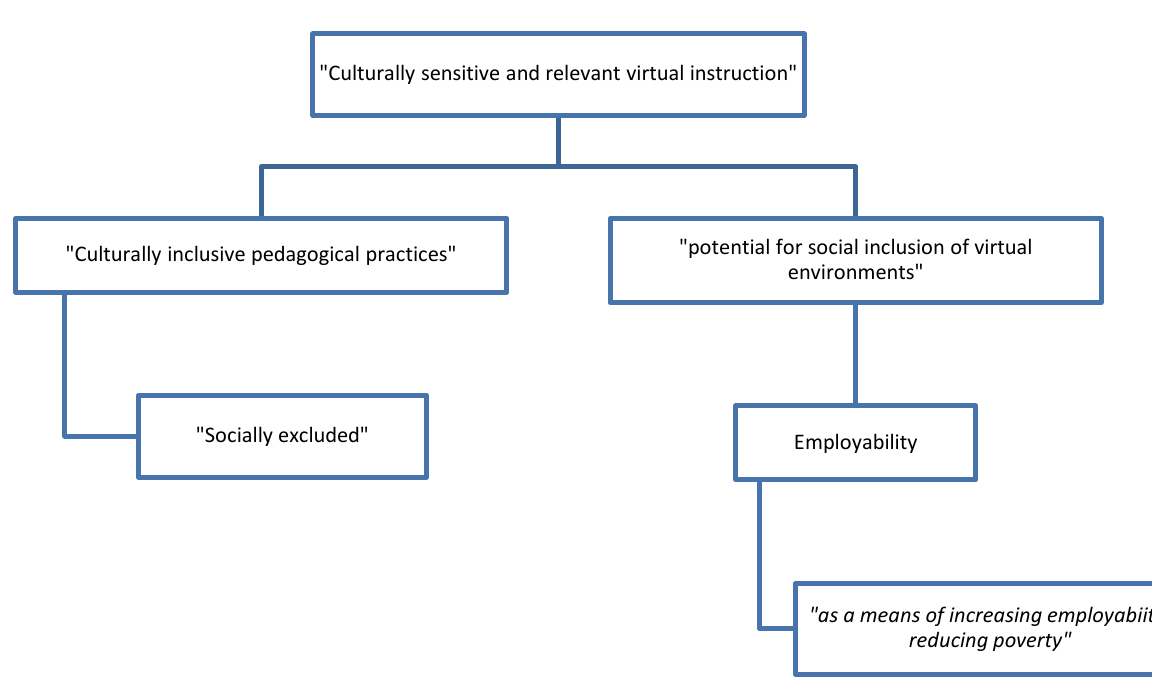
Figure 6 . Contributions to the learning process generated by distance education. This mind map illustrates the property and its dimensions. The dimensions give off codes, with some of them framed in quotation marks and italics. This is because they are "in vivo" codes and/or quotations from some of the articles studied, while the others are codes created by the